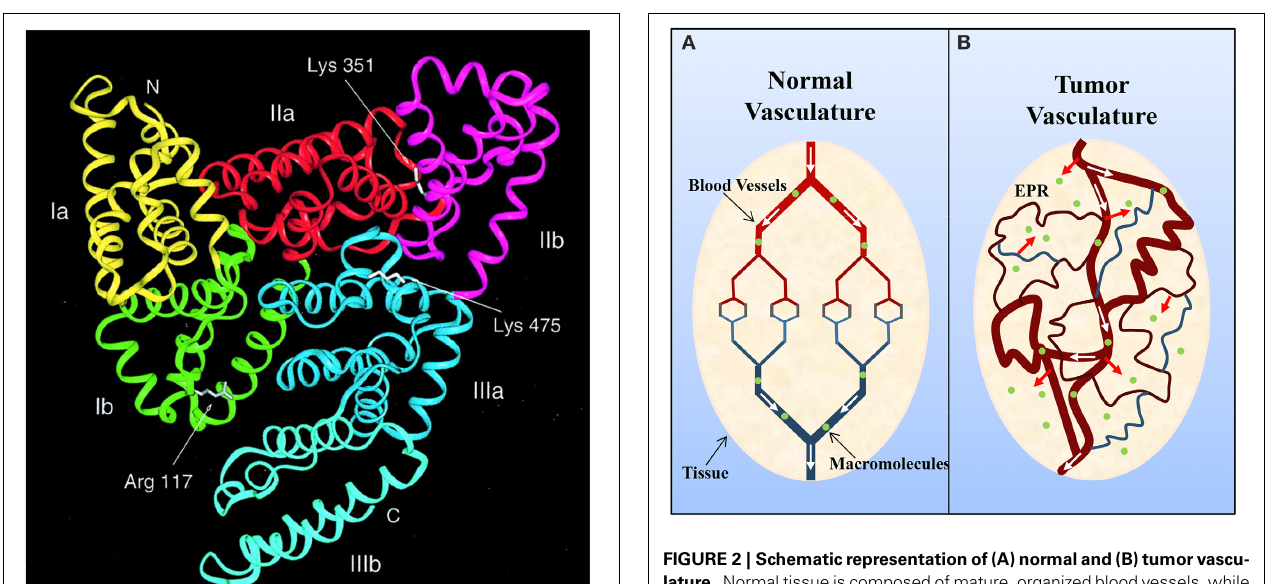
a mouse sarcoma model (C57/RL6J) injected with 3